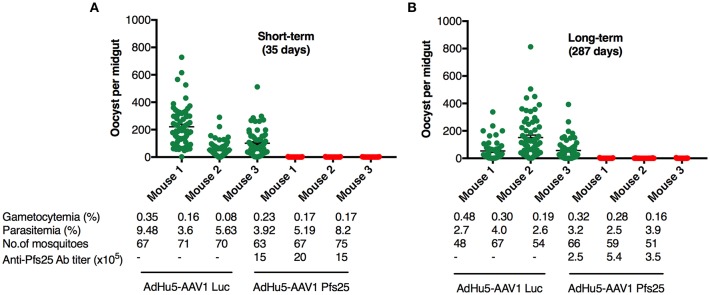
Transmission-blocking efficacy of the AdHu5-Pf25-prime and AAV1-Pfs25-boost regimen. (A,B) Groups of BALB/c mice (n = 3) were immunized with the indicated regimen at a 6-week interval and infected with Pfs25DR3 at 35 days (A) or 287 days (B) after boost. Mosquitoes were allowed to feed on the infected mice for a DFA. At day 10–12 post-feeding, the mosquito midguts were dissected, and oocyst intensity and prevalence were determined (Table 2). Each datapoint represents a single mosquito blood-fed on each mouse. The x-axis points represent individual mice. Horizontal lines indicate the mean numbers of oocysts observed (± standard errors of the means [SEM]).